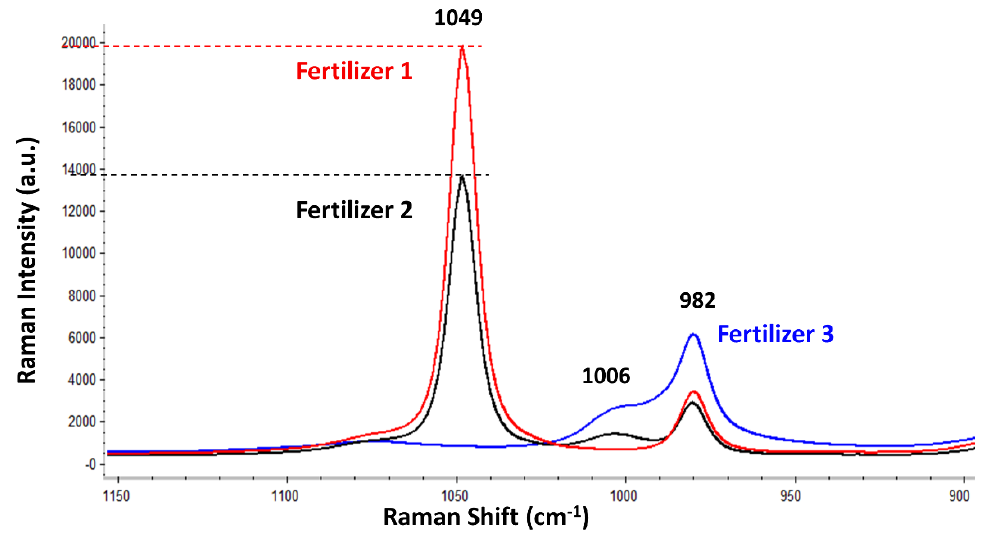
Figure 4. Average Raman spectra (from five replicates) from the fertilizer 1 (red), fertilizer 2 (black), and fertilizer 3 (blue). All spectra are displayed using the same scale and no vertical offset.